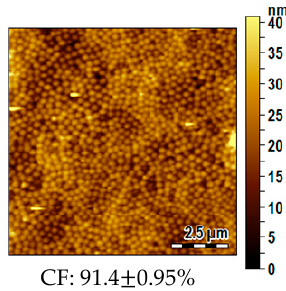
Figure 6. AFM image of the MGs film realized onto the gold coated fiber tip with the optimized procedure (dipping: 1 min, drying: 10 min, rinsing: 10 min).